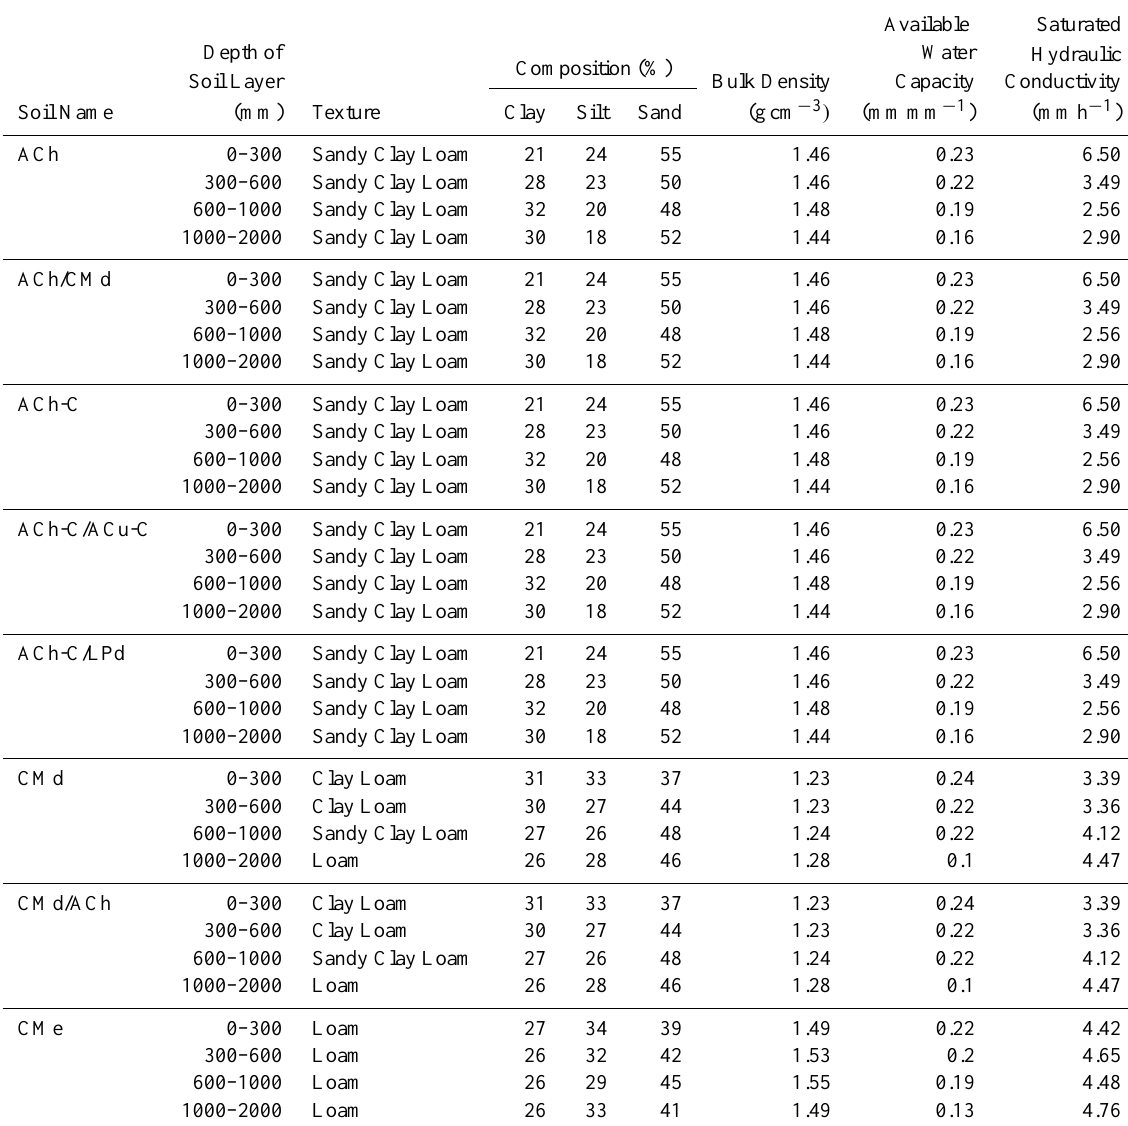
Table 1. Major soil types and their properties in the Nam Ou basin (the values in the table are based on soil map used in the SWAT model of the whole Mekong Basin developed by Mekong River